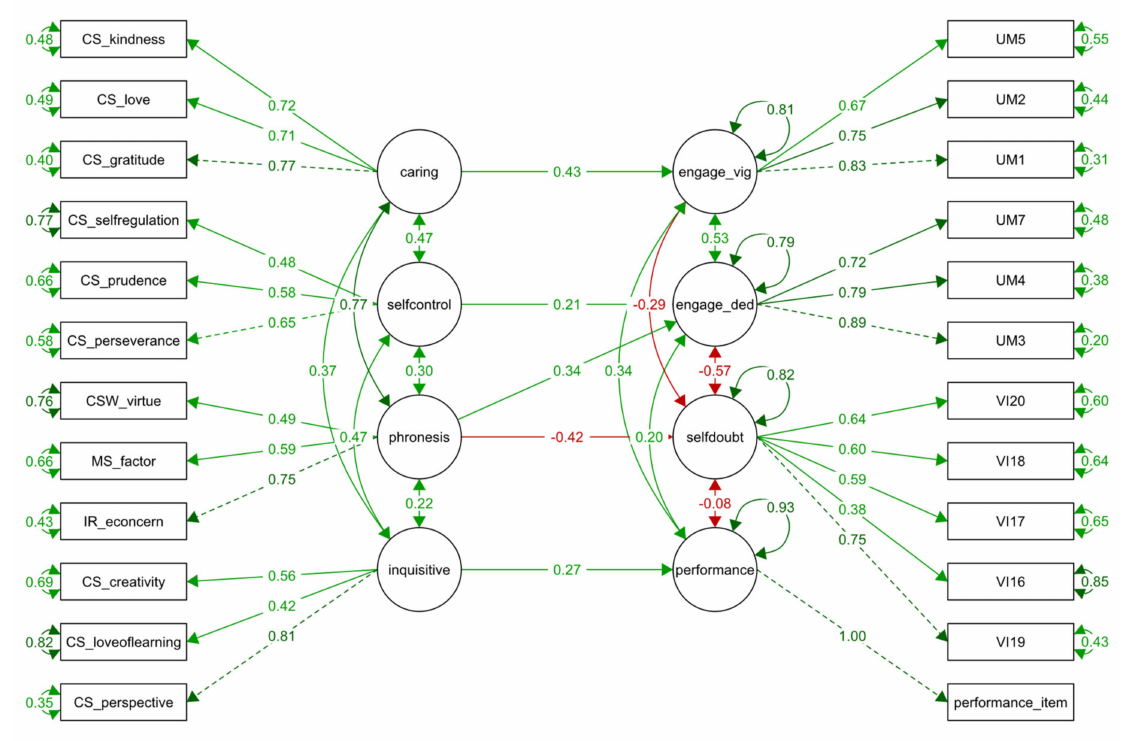
Figure 1. Model M4. Character Strength Factors and Phronesis Motivation as predictors of academic engagement (engage_vig = vigour dimension; engage_ded = dedication dimension), career self-doubt (self-doubt) and academic perfor- mance (performance), SEM diagram of standardized estimates. Coefficients in green represent positive values (>0), and coefficients in red are negative values (<0).